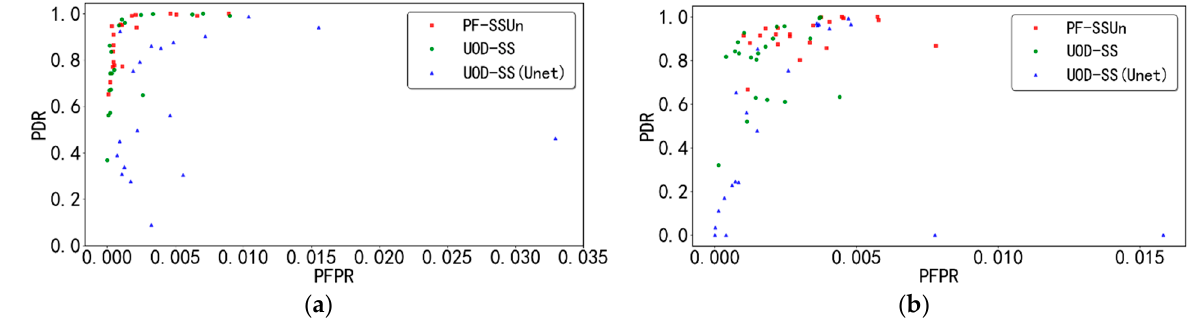
( b ) Figure 8. Comparison of frame-by-frame detection rate of the three semantically relevant methods: ( a ) Scene 1; ( b ) Scene 2. Figure 9 shows the PDR over PFPR scatter plots for the three methods in the two scenes. A high detection rate and low false-positive rate (upper left corner of the figure) can reflect the best detection performance. As shown in the figure, the marked points of